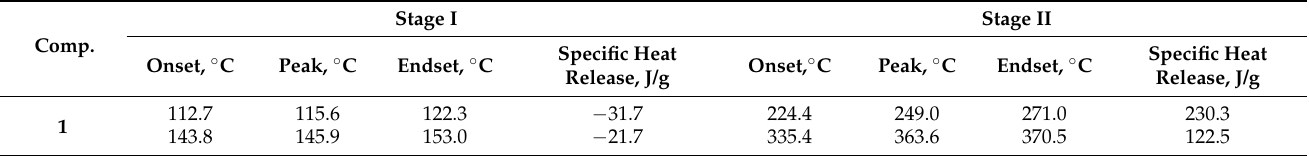
Table 8. DSC data for decomposition temperatures of 1